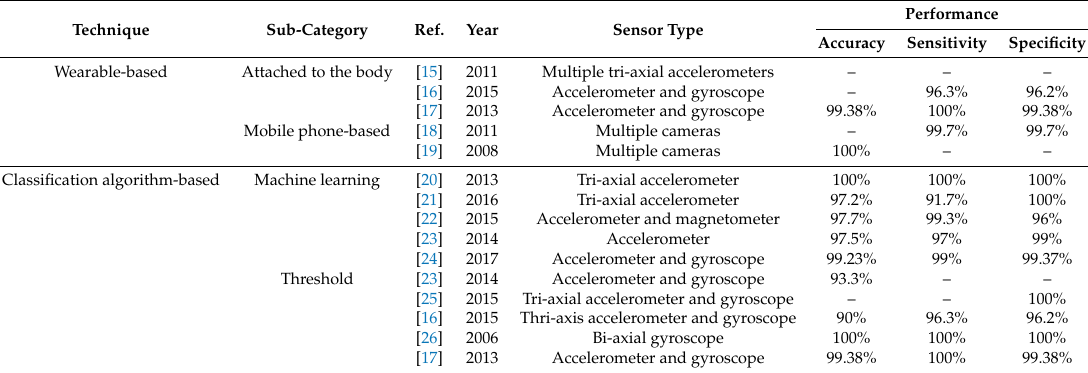
Table 1. Fall detection research